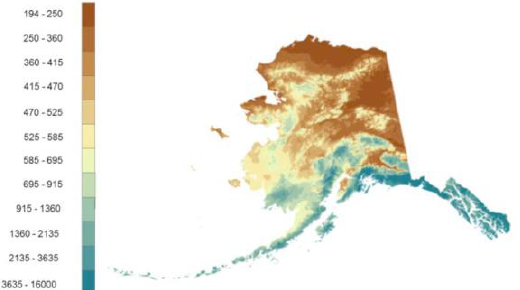
Figure 1. Mean annual precipitation for past decade in